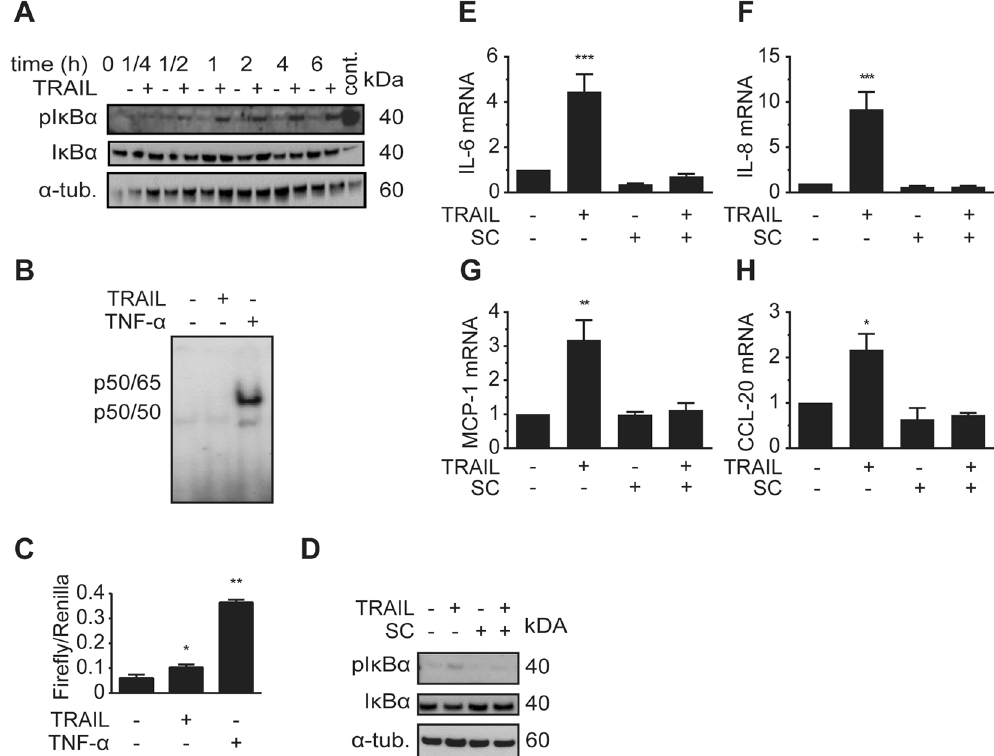
Figure 5. TRAIL induces the phosphorylation of I κ B α . ( A ) SGBS adipocytes on day 14 of adipogenic differentiation were treated with TRAIL (30 ng/ml) or vehicle and protein was isolated at different timepoints (1/4, 1/2, 1, 2 and 6 hours). Cells stimulated with macrophage-conditioned medium (MaCM) were used as a positive control. The phosphorylation of I κ B α was analyzed by Western blot. α -tubulin was used as a loading control. One representative blot out of three performed experiments is presented. ( B ) SGBS adipocytes on day 14 of adipogenic differentiation were treated for 2 hours with TRAIL (30 ng/ml), TNF- α (30 mg/ml) or vehicle and nuclear extracts were prepared. DNA binding activity of NF κ B was analyzed by electrophoretic mobility shift assay (EMSA). One representative experiment out of three performed experiments is presented. ( C ) SGBS adipocytes on day 7 of adipogenic differentiation were transfected with NF κ B Firefly luciferase reporter vector and Renilla luciferase control reporter vector. On day 9, cells were treated for 24 hours with TRAIL (30 ng/ml), TNF- α (30 mg/ml) or vehicle and luciferase activity was determined. Values are means and SEM of 3 different experiments. Unpaired Student´s t-test was used to test for statistical significance. ( D-H ) SGBS adipocytes on day 14 of adipogenic differentiation were treated with TRAIL (30 ng/ml) or vehicle in the absence or presence of the IKK inhibitor SC-514 (100 μ M). After 6 hours, the phosphorylation of I κ B α was analyzed by Western blot ( D ). α -tubulin was used as a loading control. One representative blot out of three performed experiments is presented. Also, the expression of IL-6 ( E ), IL-8 ( F ), MCP-1 ( G ) and CCL-20 ( H ) was assessed by qPCR. The mRNA levels were normalized to HPRT. Depicted are the means and SEM of 4 independent experiments. One-way ANOVA and Dunnett’s multiple comparison were used to test for statistical significance. * p < 0.05, ** p < 0.01, *** p <